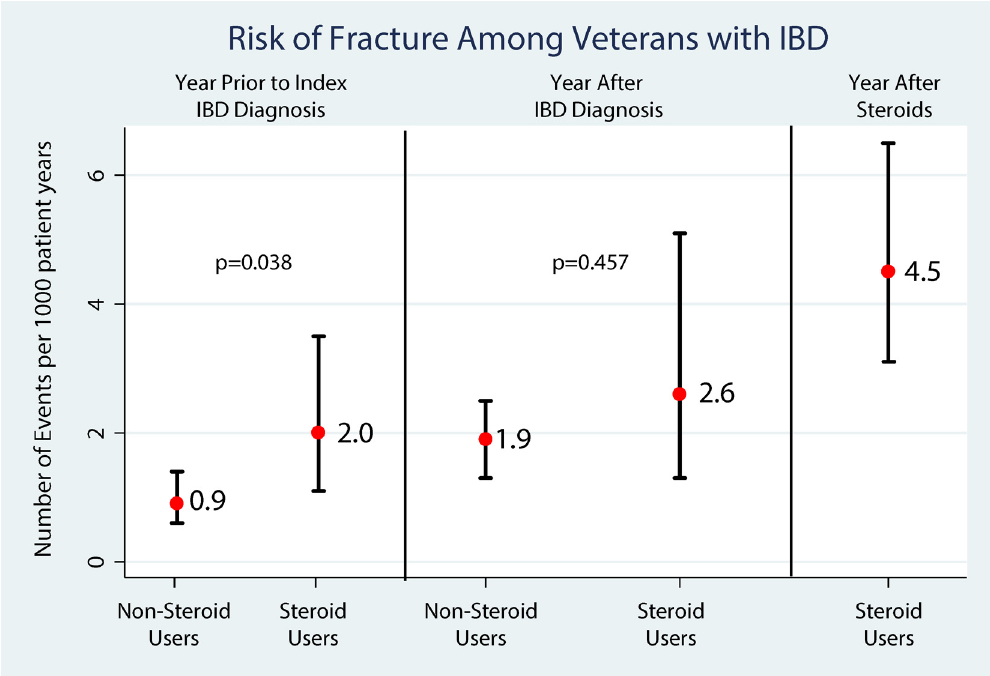
Fig 5. Risk of Fragility fractures among Veterans with IBD.